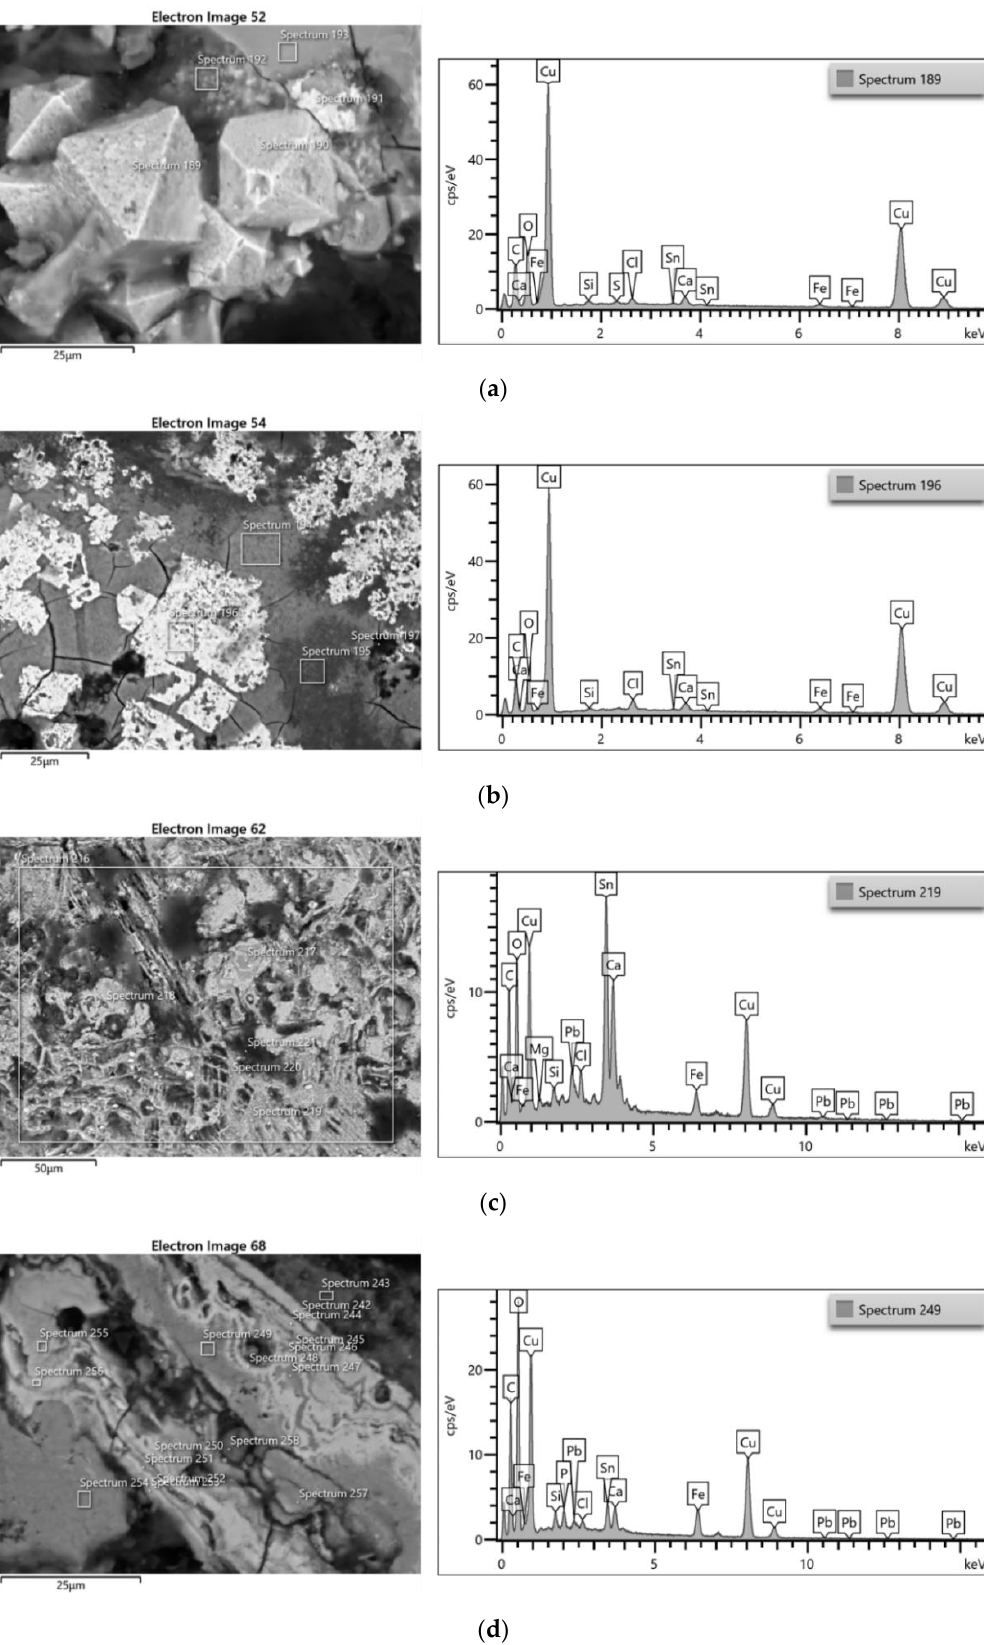
Figure 14. SEM images and EDS spectra of the sample 3: ( a – d ) detailed spectra for each area selected.